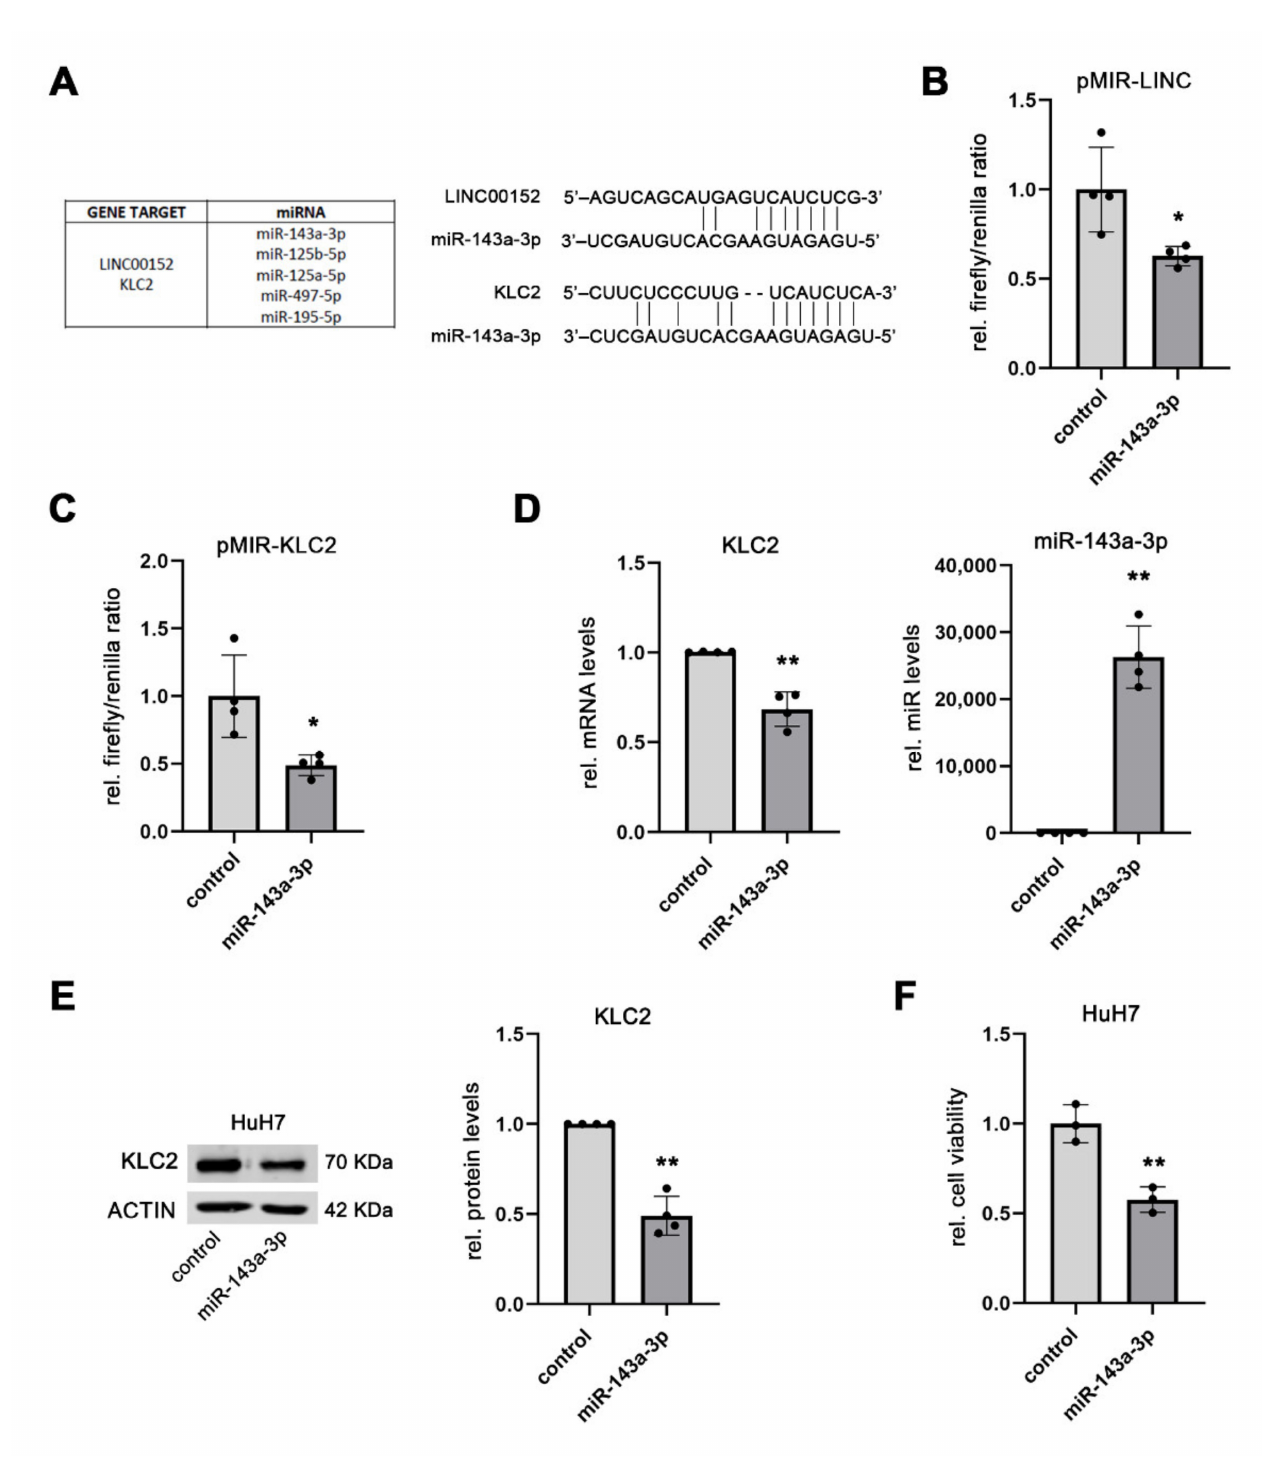
Figure 4. LINC00152 controls the bioavailability of miR-143-3p. ( A ) Putative miRNA components of the LINC00152 ceRNA network showing binding sites for both LINC00152 and KLC2 . ( B , C ) Reduced luciferase reporter activity due to binding of a miR-143a-3p mimic to LINC00152 respectively KLC2 in HuH7 cells. ( D , E ) Decreased KLC2 mRNA and protein levels following miR-143a-3p mimic transfection in HuH7 cells. ( F ) Transient miR-143a-3p overexpression lowered the cell viability of HuH7 compared to control cells. Data are presented as mean ± SD of at least 3 independent experi- ments. Student t -test in panel ( F ) and Welch’s t -test for ( A – E ): * p < 0.05, ** p < 0.01. Abbreviations: rel.,